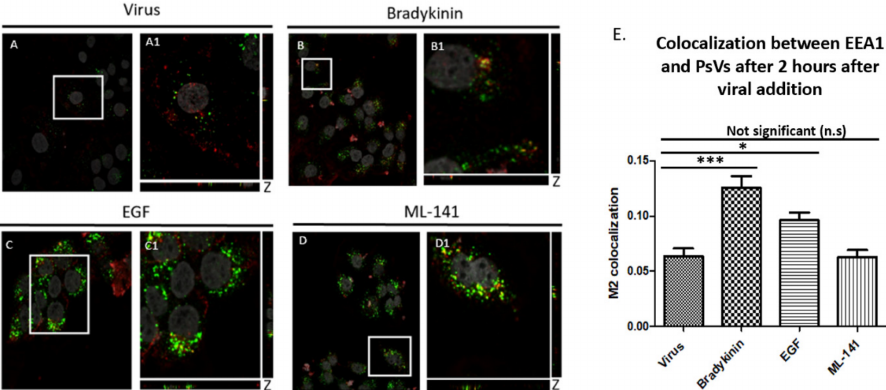
Figure 6. Filopodia inducer drugs increase internalization of PsVs into HaCaT cells. Colocalization measured the amount of PsVs (red) that was trafficked to the early endosome (green). Confocal microscopy images of cells treated with virus and drug for 2 h. Cells treated with virus ( A , A1 ), 200 ng/mL bradykinin ( B , B1 ), 200 ng/mL EGF ( C , C1 ), and 10 µ M ML-141 for 2 h ( D , D1 ). DAPI was used to stain cell nuclei (grey), H16.V5 antibody was used to stain L1 capsid protein (red), and EEA1 was used to stain for early endosome (green). Zoomed in images ( A1 – D1 ). Colocalization of PsVs and EEA1 appeared yellow. The JACoP plugin for ImageJ was used to measure the M2 coefficient (fraction of red overlapping with green) with six confocal Z-scans for each condition. Graph representation of colocalization of six confocal scans ( E ). Statistical difference was determined by an ANOVA Dunnett’s multiple comparison test (samples compared to control infection, n = 6, *, p < 0.5, ***, p < 0.001). Average was displayed with